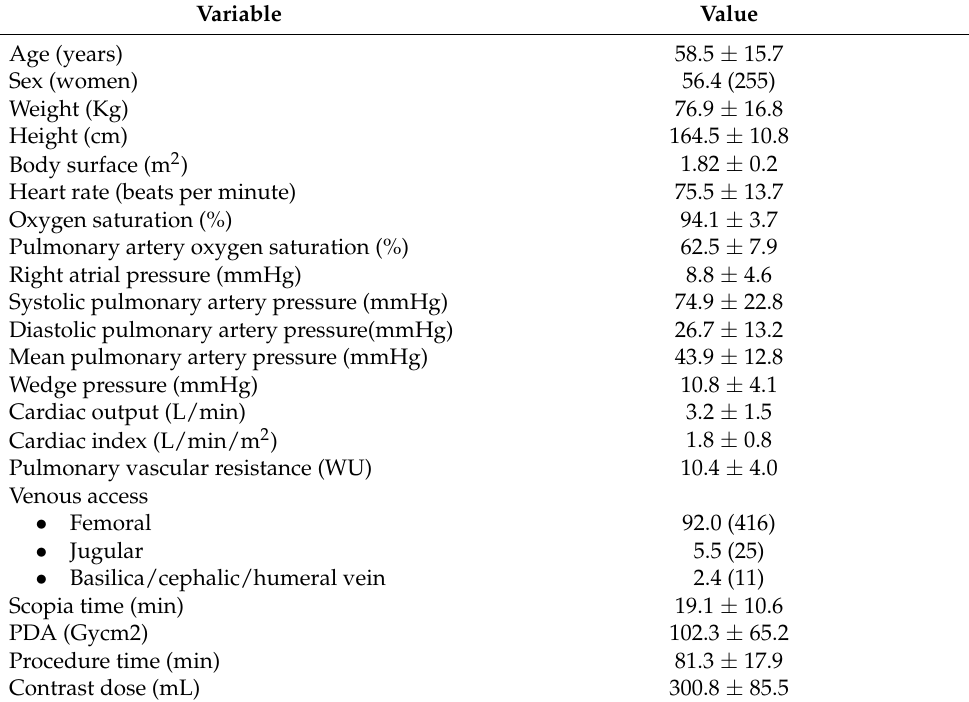
Table 1. Procedural and clinical